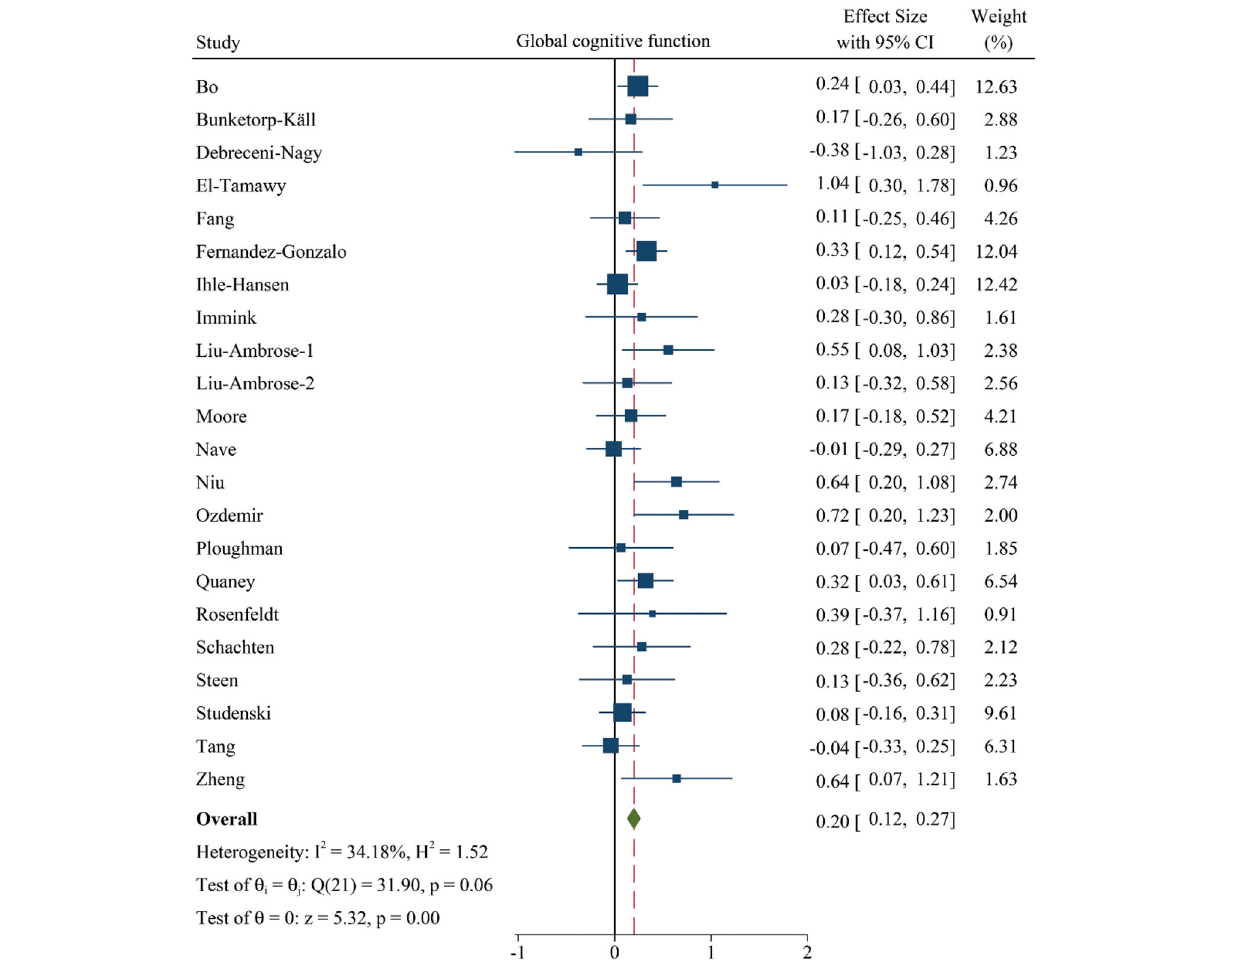
the patients with objective cognitive assessment. There was no significance in the interaction effect between groups ( Q B = 1.47; p = 0.23, Figure 3 and Supplementary Figure 6